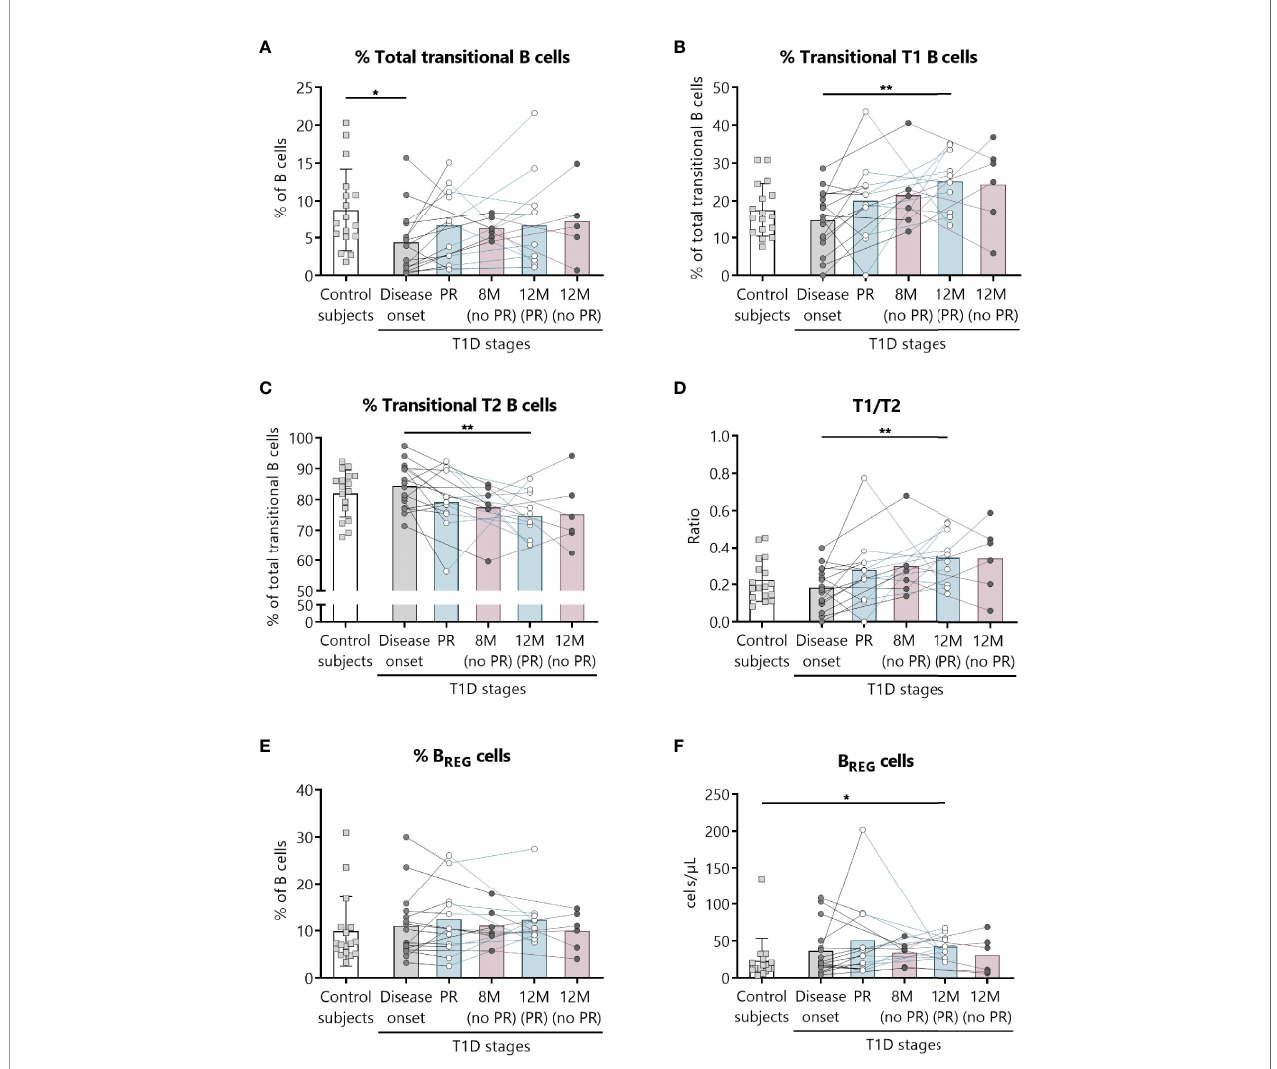
FIGURE 5 | Two regulatory subsets of B lymphocytes are quantitatively altered at the initial stages of T1D. Percentages (%) of (A) total transitional B lymphocytes and of their subdivision into (B) T1, and (C) T2, (D) the T1/T2 ratio, and (E, F) the percentage (%) and concentration (cells/µl) of B REG were determined in peripheral blood of controls and patients with T1D at different time-points. Squares represent controls ( n = 17) (white bar), and patients are represented by light gray dots at disease onset ( n = 16) (gray bar), white dots during PR phase ( n = 11) and for remitter patients at 12 months (12 M PR) ( n = 10) (blue bars), and dark gray dots for non-remitter patients at 8 months (8 M no PR) ( n = 6) and 12 months (12 M no PR) ( n = 6) (pink bars). Bar graphs show mean percentage or absolute count values. Each symbol represents an individual patient. Lines link the same patient throughout the time-points. * P ≤ 0.05, ** P < 0.01 after mixed effects model with Tukey ’ s post-hoc test for longitudinal data, or Kruskal – Wallis with Dunn ’ s post-hoc test for comparisons between control subjects and the different T1D time-points. P ≤ 0.05 is considered signi fi